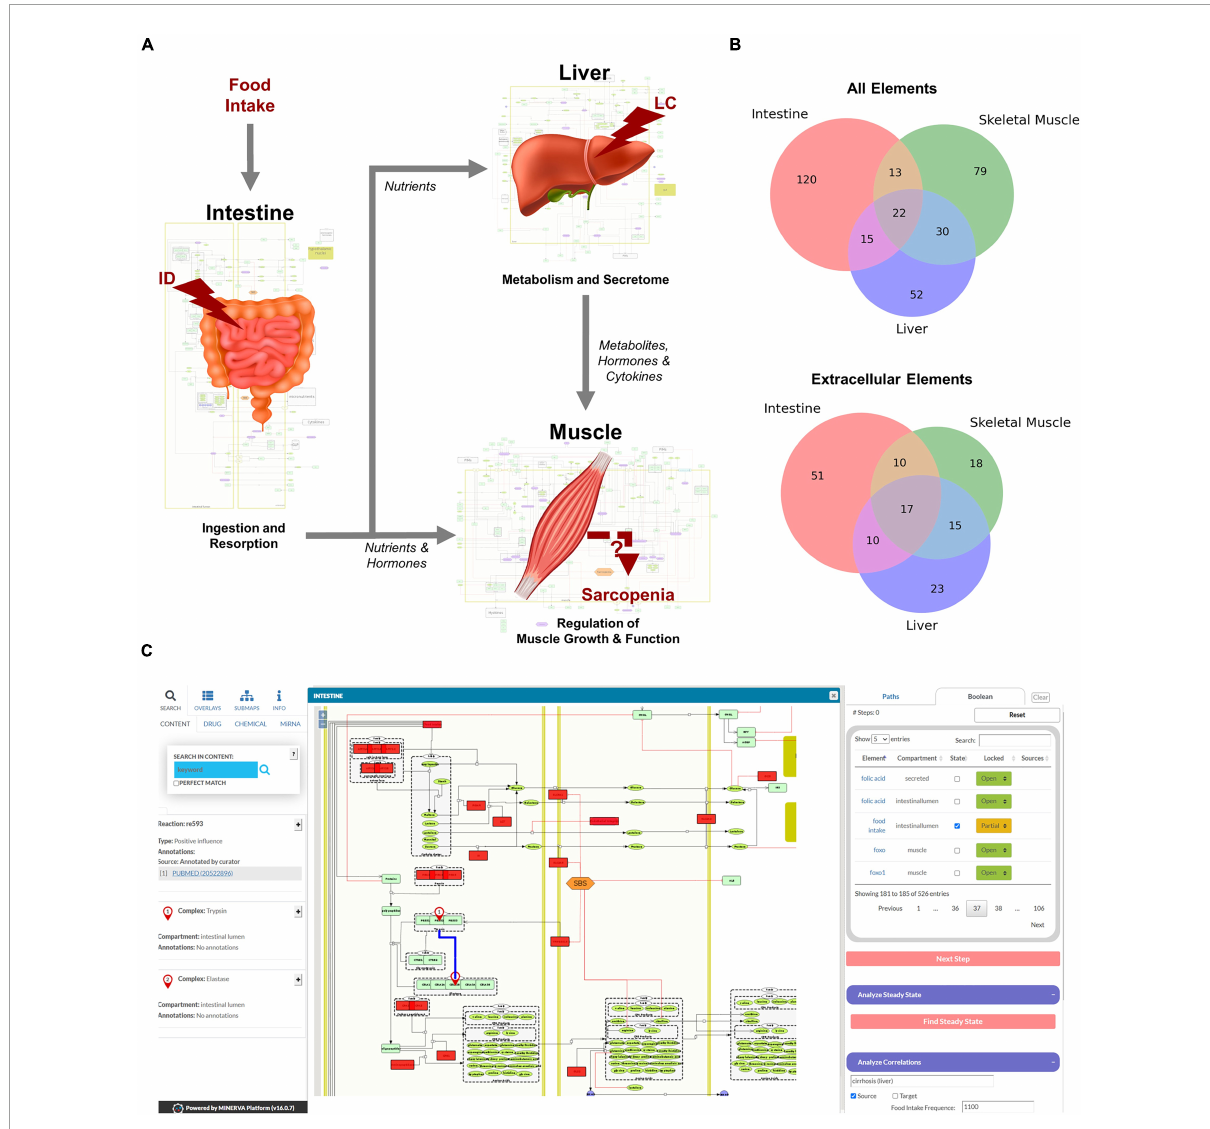
FIGURE2 Overview of the hierarchical organization of the Sarcopenia map. (A) We summarized information on molecular interactions related to sarcopenia from the literature into three tissue-specific submaps. In addition, we integrated the effects of liver cirrhosis (LC) and intestinal dysfunction (ID) on these molecular processes. (B) Venn Diagrams of element distributions between the different tissues. (C) The interactive user interface of the Sarcopenia Map enables the exploration of information, as well as simulations of molecular